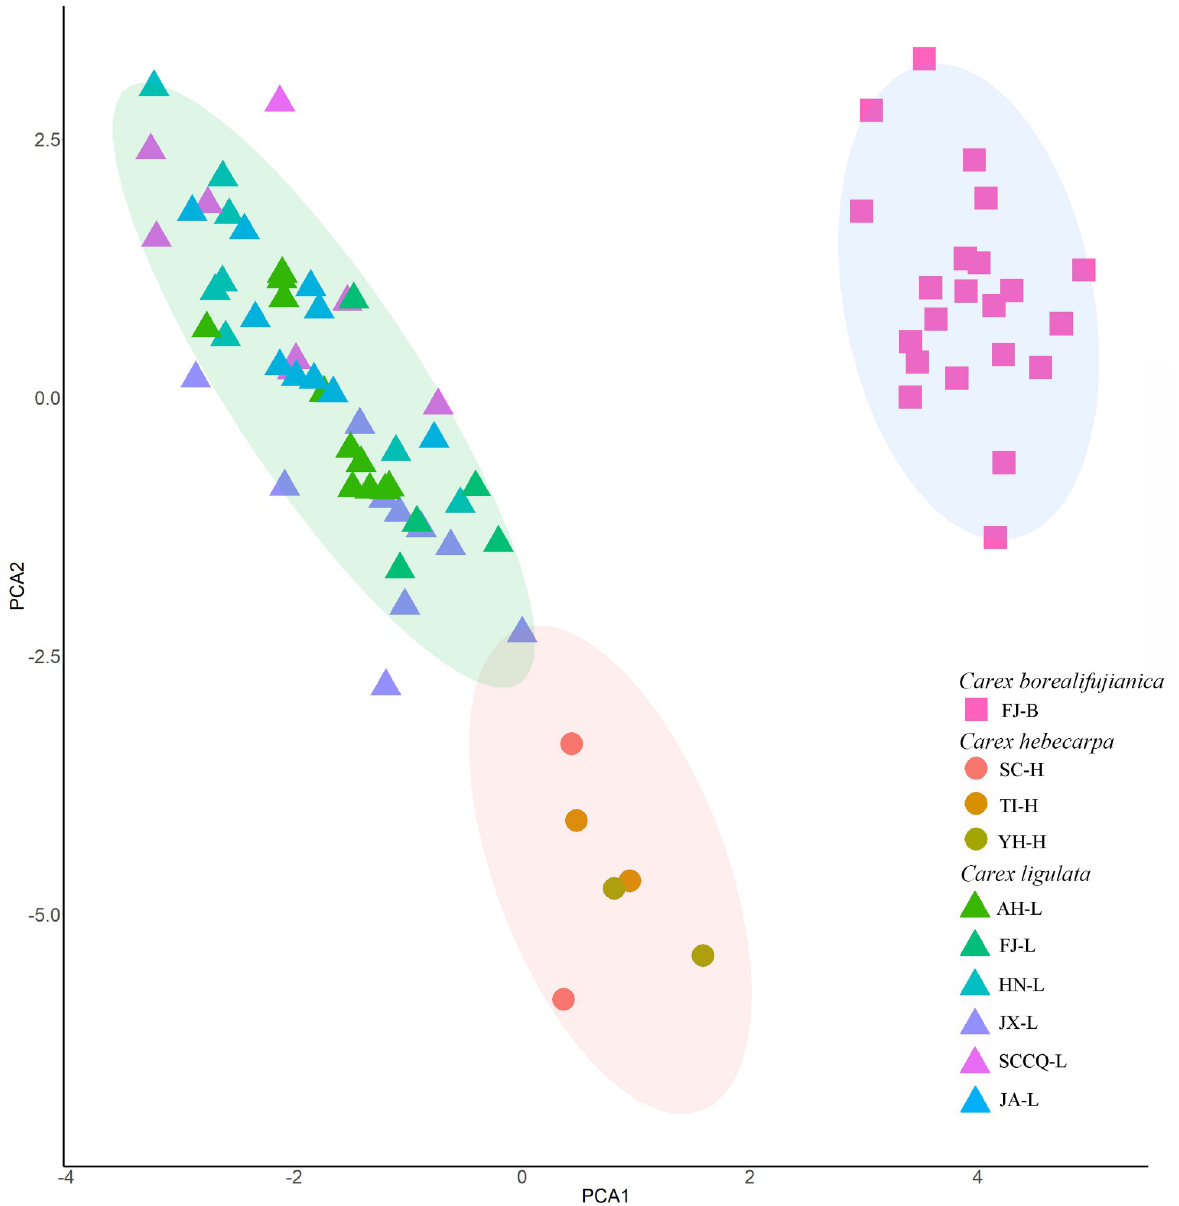
Fig 1. Principal component analysis of ten populations based on analysis of 17 diagnostic characters from 80 individuals. Populations names and detailed information follow Table